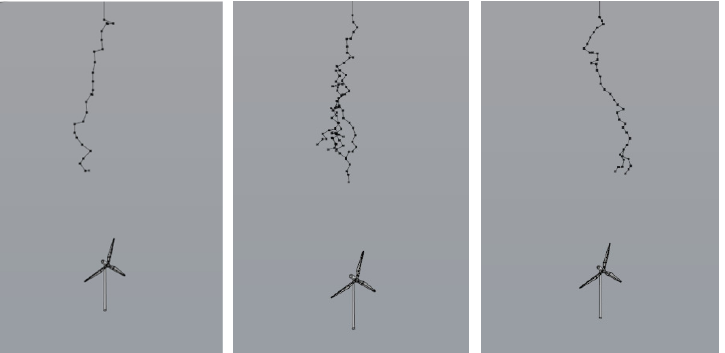
Figure 15. Three ‐ dimensional stochastic development simulation results of a typical lightning downward leader. downward